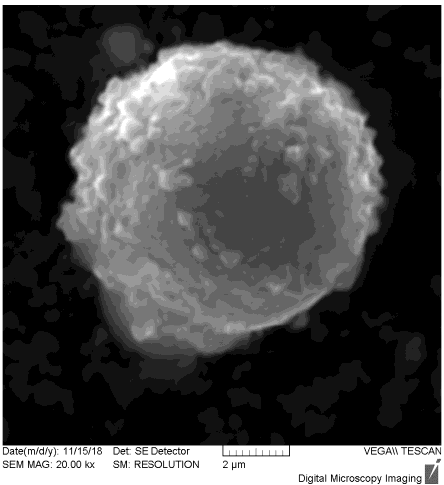
Figure 1. Shape of bronze powder particles. EED in distilled water ×20,000. The morphology and shape of the microparticles were determined using a TESCAN VEGA II (TESCAN, Brno, Czech Republic) raster electron microscope with an X-ray spectral analysis system INCA Energy 350 (Oxford Instruments Analytical, London, UK).